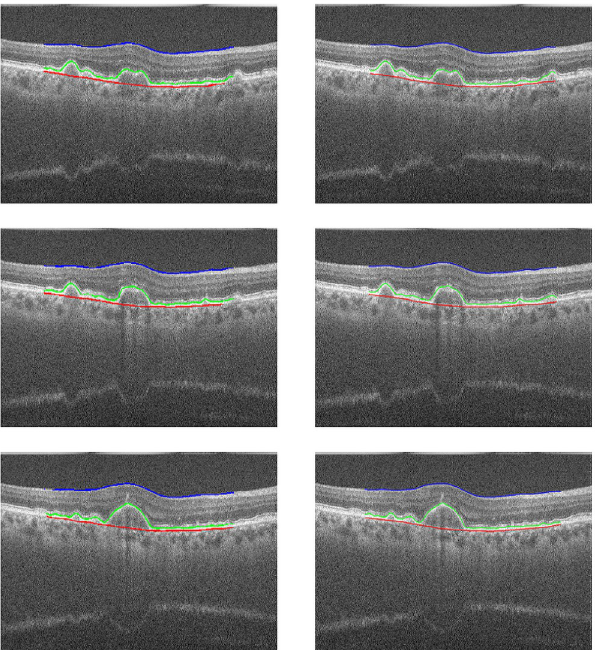
Fig 9. Examples of success cases. Images from the exam “AMD _1090”, in the left column are the results of our method, the dataset annotation is in the right column.